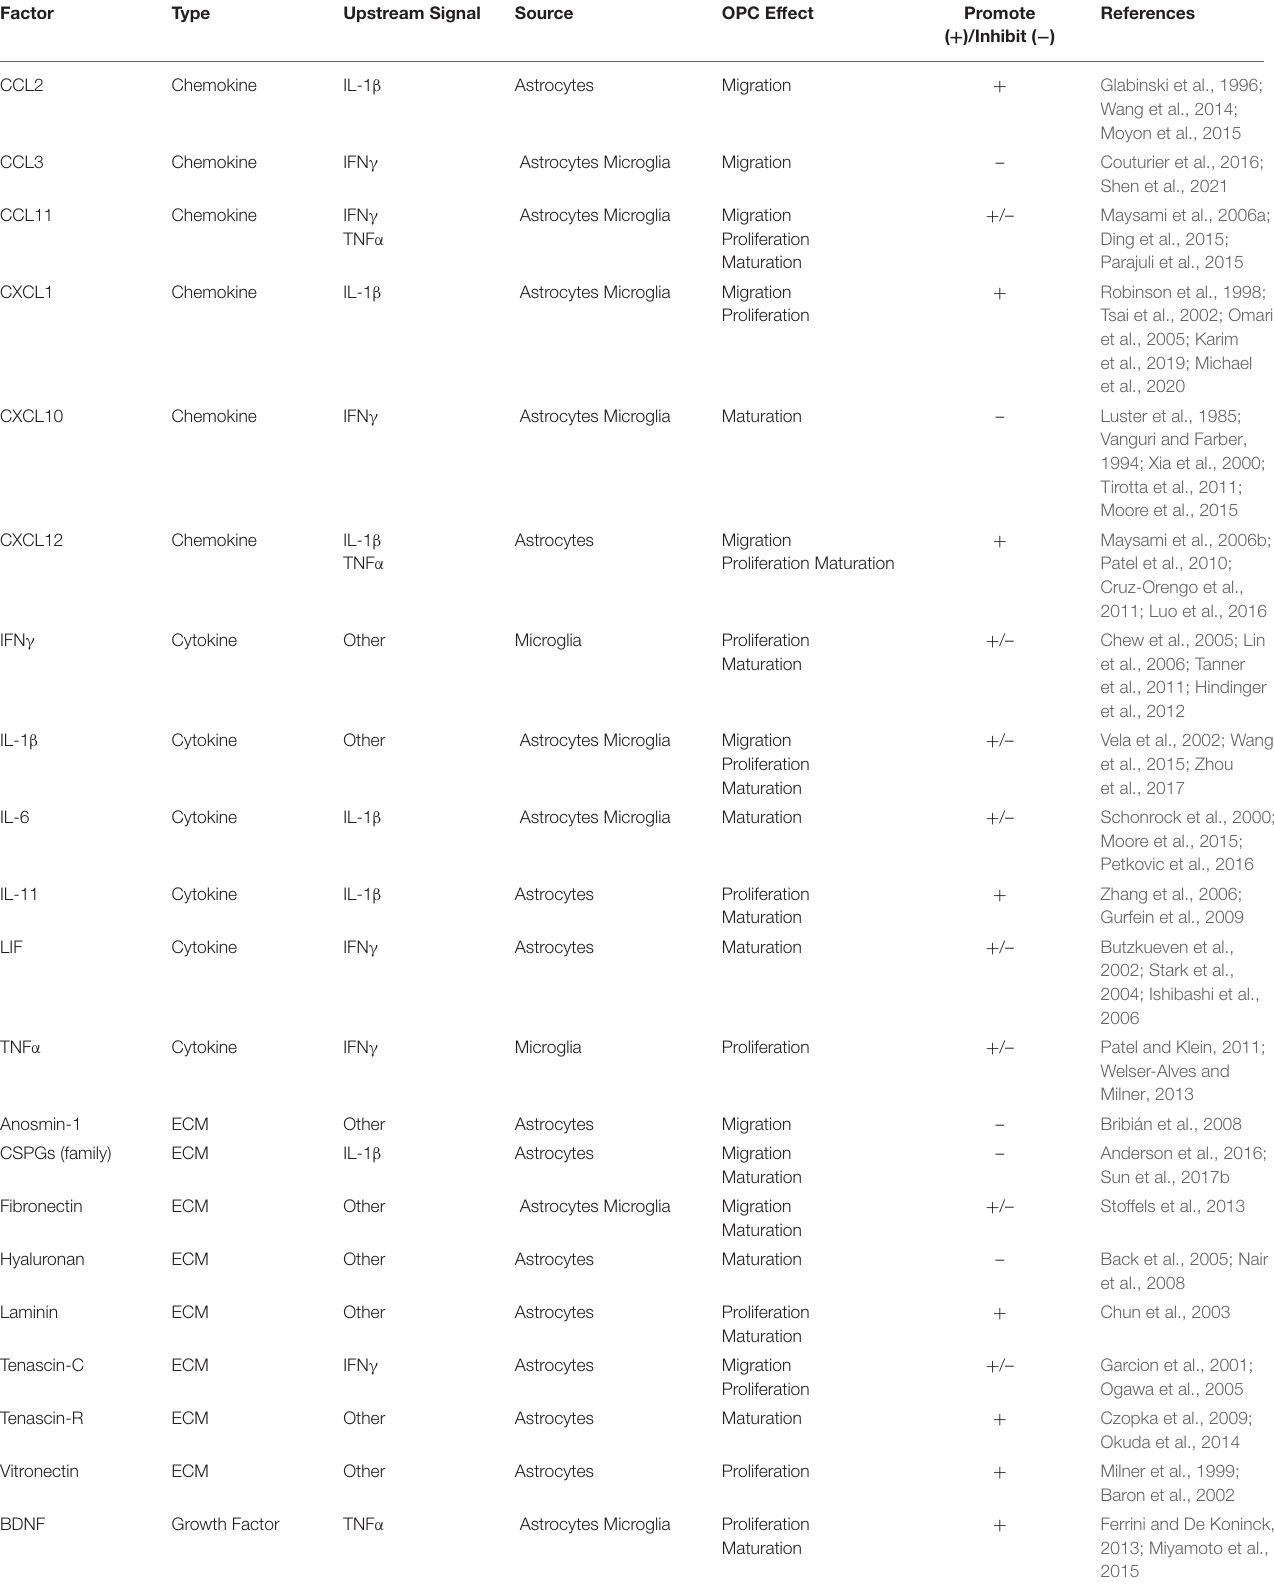
TABLE 1 | CNS-derived factors that modulate OPC